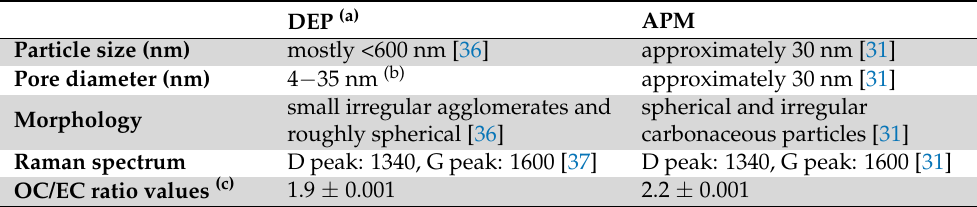
Table 2. Characterization of DEP and